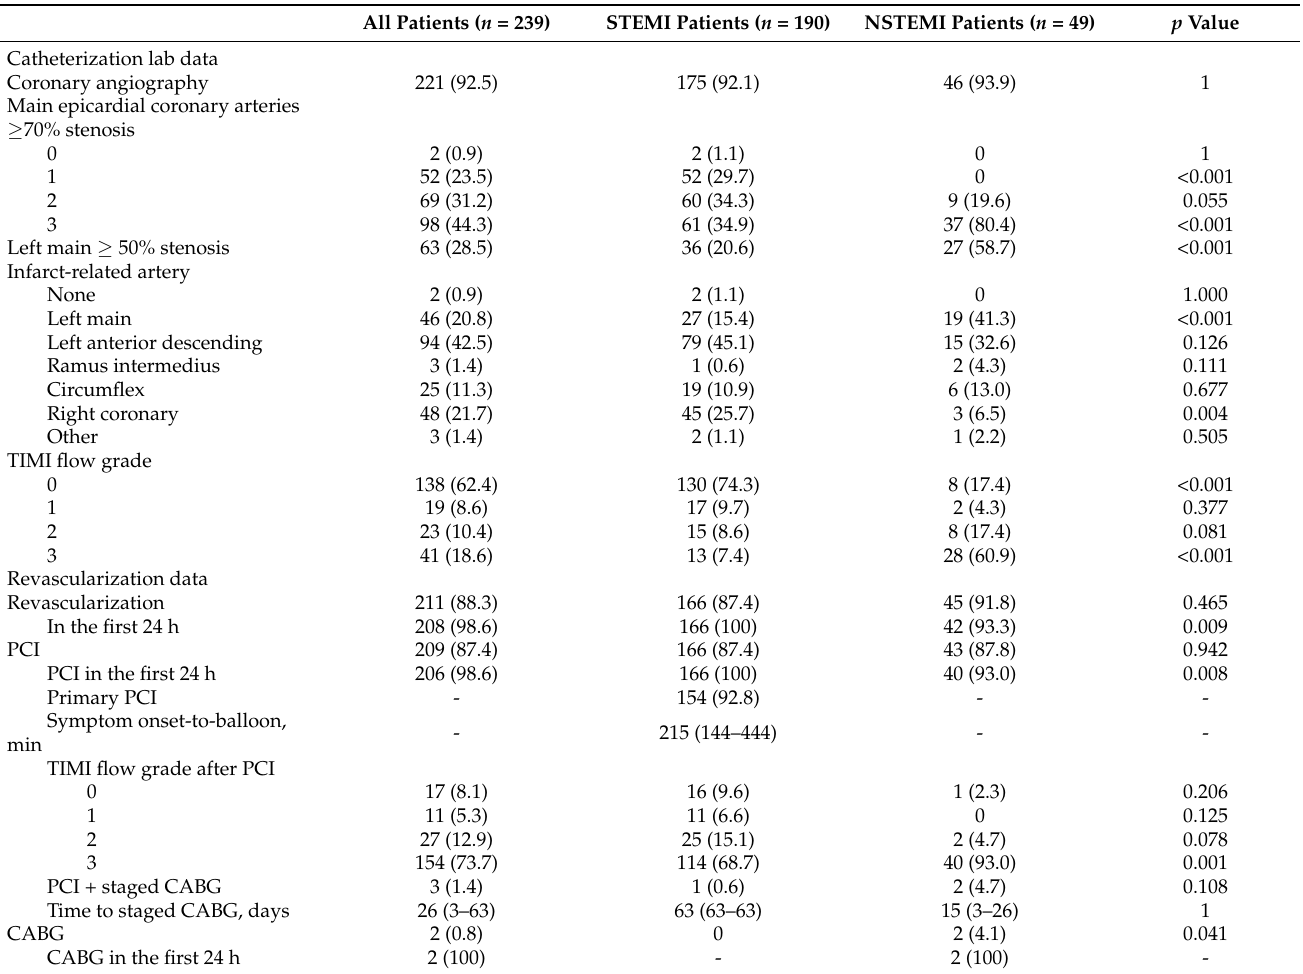
Table 2. Coronary anatomy and revascularization based on presentation with or without ST- segment